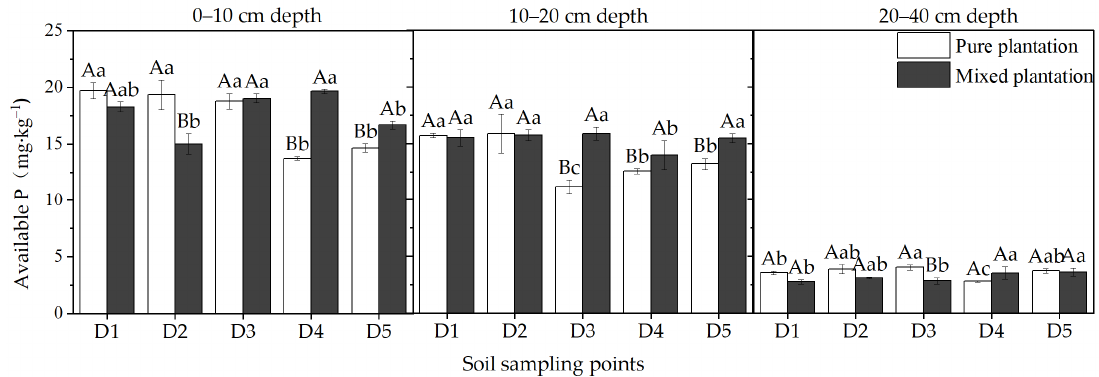
Figure 5. Concentrations of available P at different soil sampling points in the pure larch plantation and mixed larch-ash plantation. Lowercase letters indicate significant differences among different soil sampling points in the same plantation, p < 0.05; capital letters indicate significant differences among different plantations at the same sampling point, p < 0.05. n = 3, standard deviation bars are shown. Table 2. The P activation coefficient at different soil sampling points for the pure larch plantation and mixed larch–ash plantation (%). Lowercase letters indicate significant differences among differ ‐ ent soil sampling points in the same plantation, p < 0.05; capital letters indicate significant differ ‐ ences among different plantations at the same sampling point, p < 0.05. n = 3, values are means ± standard deviation.